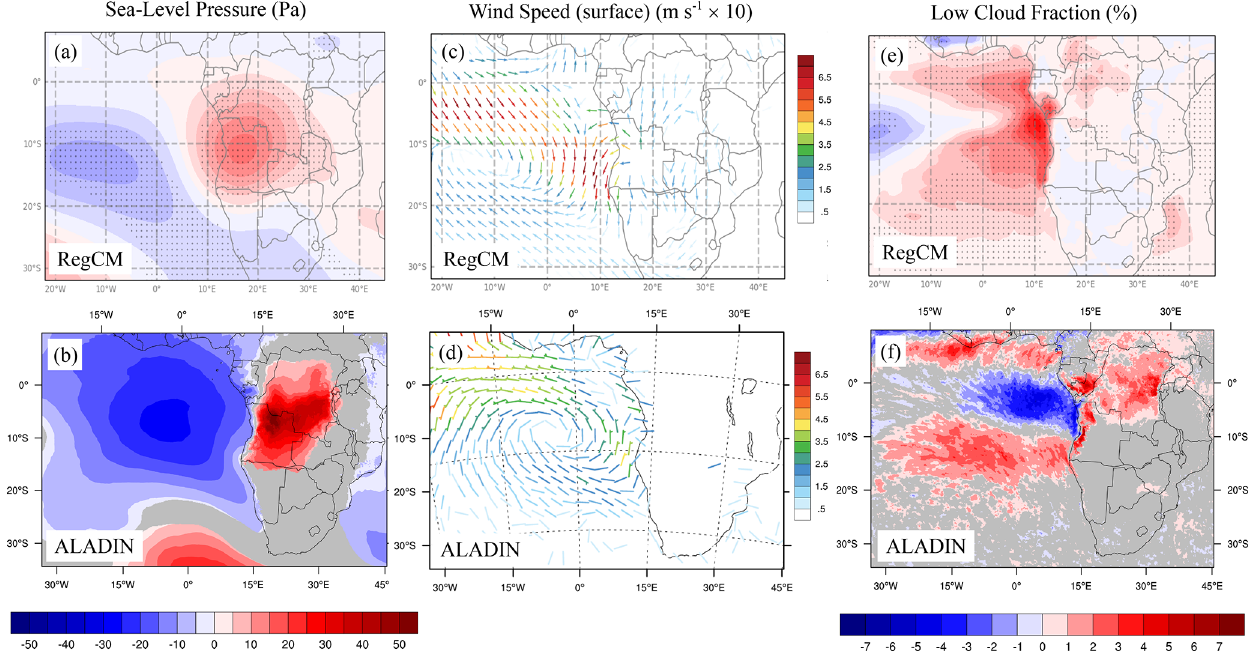
Figure 11. (a, b) Seasonal-mean (JAS) changes (SMK minus CTL simulations) in the sea-level pressure (SLP in Pa) for the ALADIN ( b , pe- riod 2000–2015) and RegCM ( a , period 2003–2015) models. (c, d) Seasonal-mean (JAS) changes in the surface wind speed. (e, f) Seasonal- mean (JAS) changes in the LCF. The grey areas in ALADIN maps (not dashed in RegCM maps) are not statistically significant at the 0.05 level.